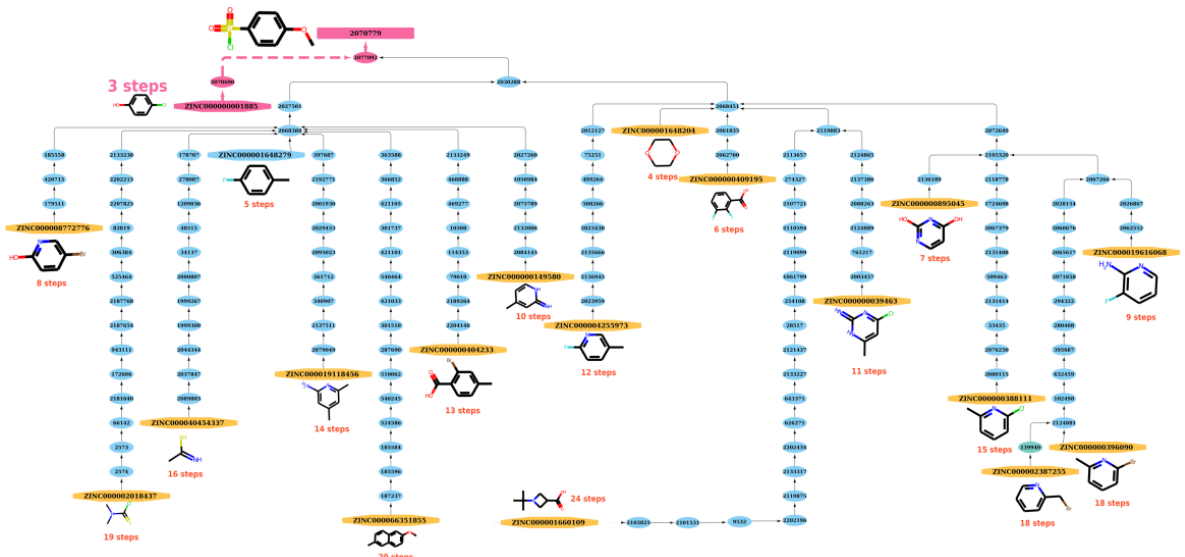
Figure 7. The reaction paths of product (node: 2070779) in the graph. After searching possible reaction paths, 19 reaction paths can be used to synthesize product from the respective ZINC starting materials. Among these options, at least 3 steps are needed (from ZINC000000001885 to node 2070779), so the SRP equals 3. Table 2. ES and HS of different partition criterion.